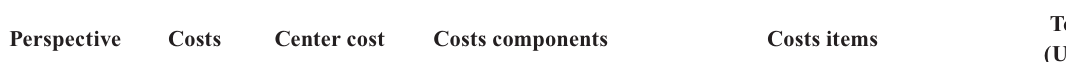
TABLE IV – Costs per centers costs of medicine dispensing service per perspective and service situation